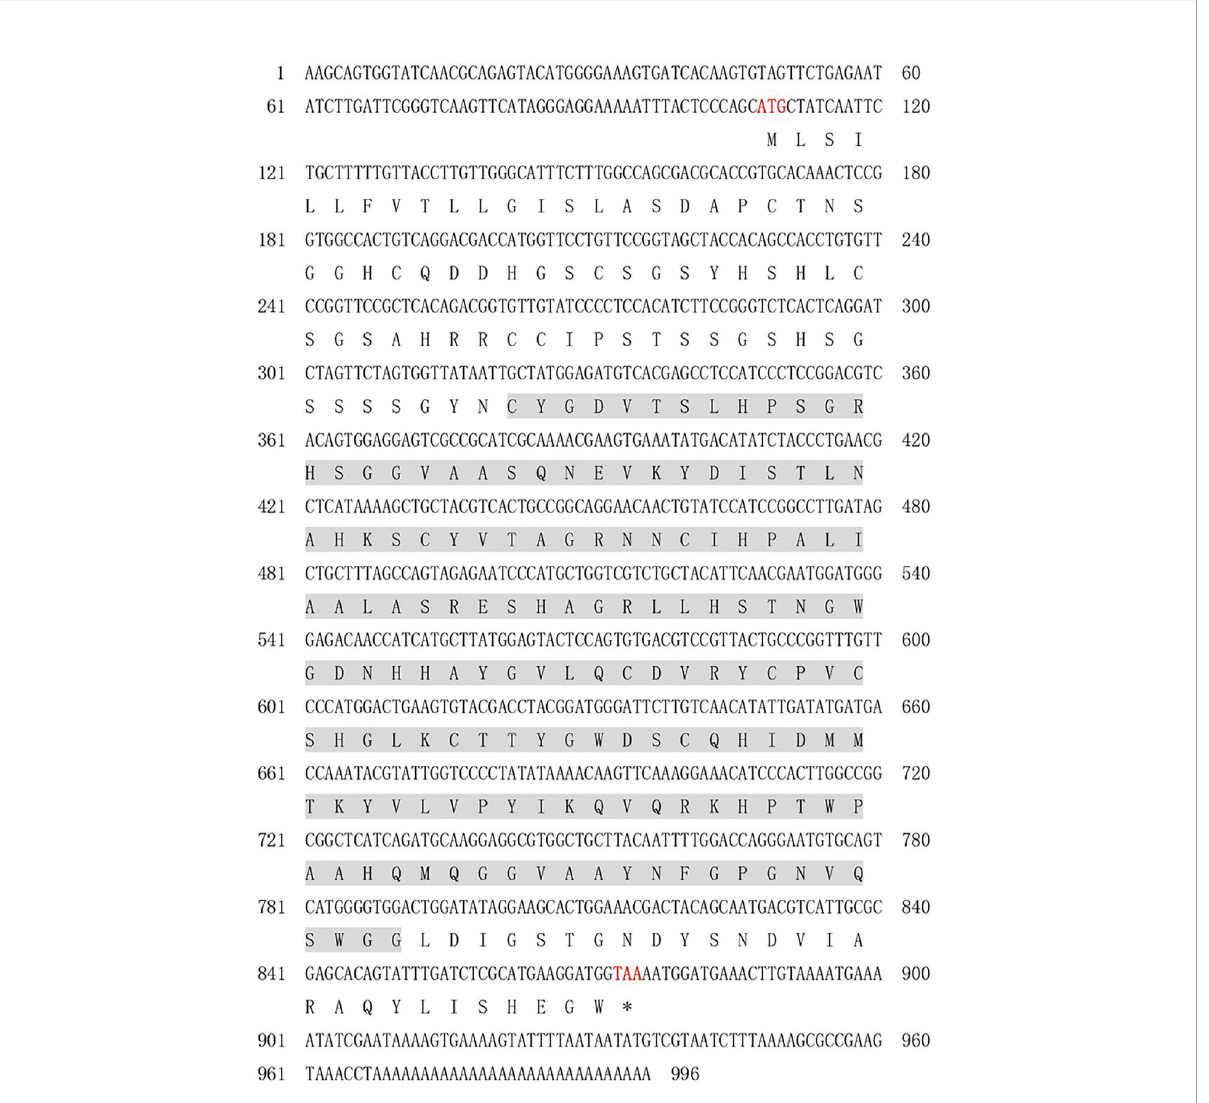
FIGURE 1 A cDNA sequence and predicted amino acid sequence of PmlysG . Red font indicates start codon and stop codon, the straight line indicates signal peptide, and the shaded portion shows the d153I_